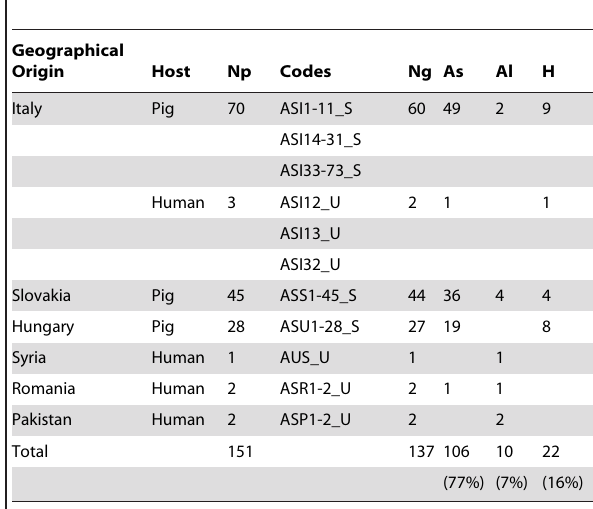
Table 1. Details of specimens analysed by PCR-RFLP approach on ITS ribosomal nuclear